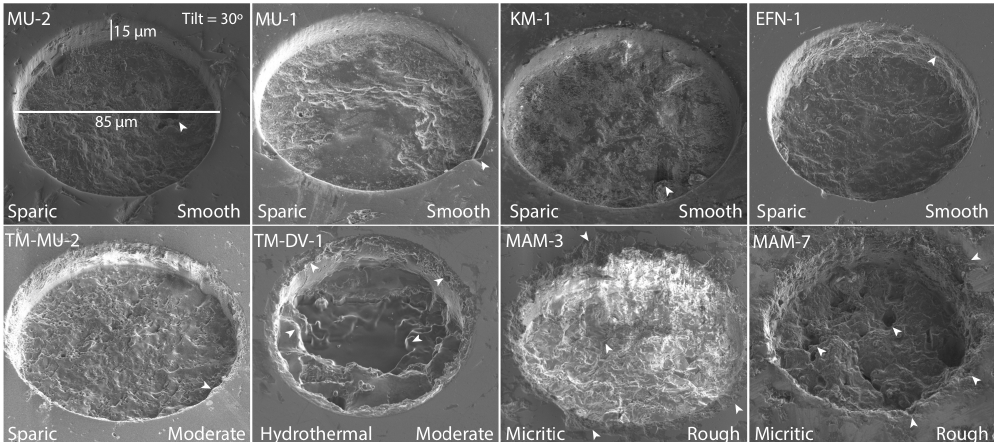
Figure 5. Ablation craters of the studied samples arranged by crater geometry and bottom roughness from smooth (MU-2, sparry dolomite), to moderate (TM-MU-2, sparry dolomite), to rough (MAM-7, micritic dolomite). Imperfections along crater rims are marked by white arrows.